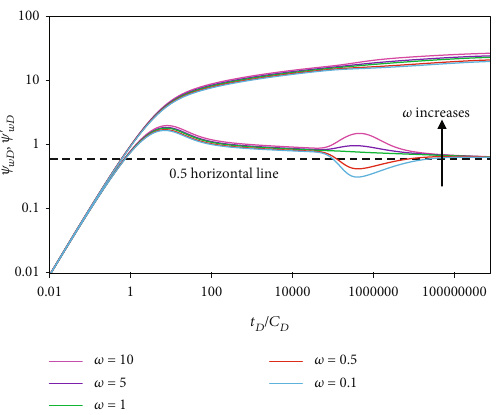
Figure 16: Well test curves of the pressure drawdown well test under di ff erent mobility ratios.